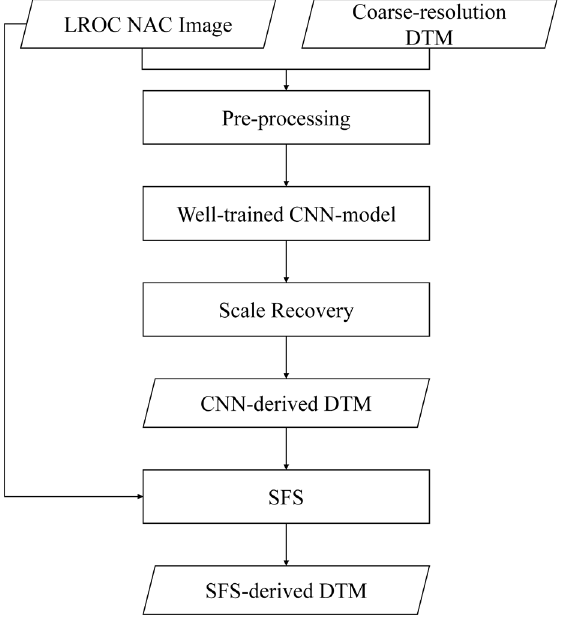
Figure 1 . Flowchart of the DTM generation